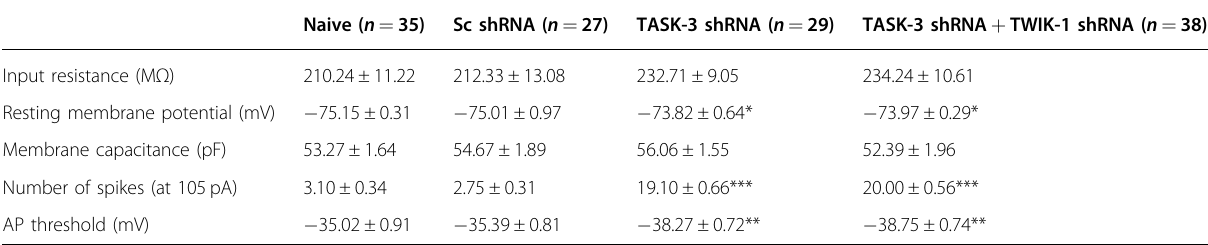
Table 1 Electrical properties of